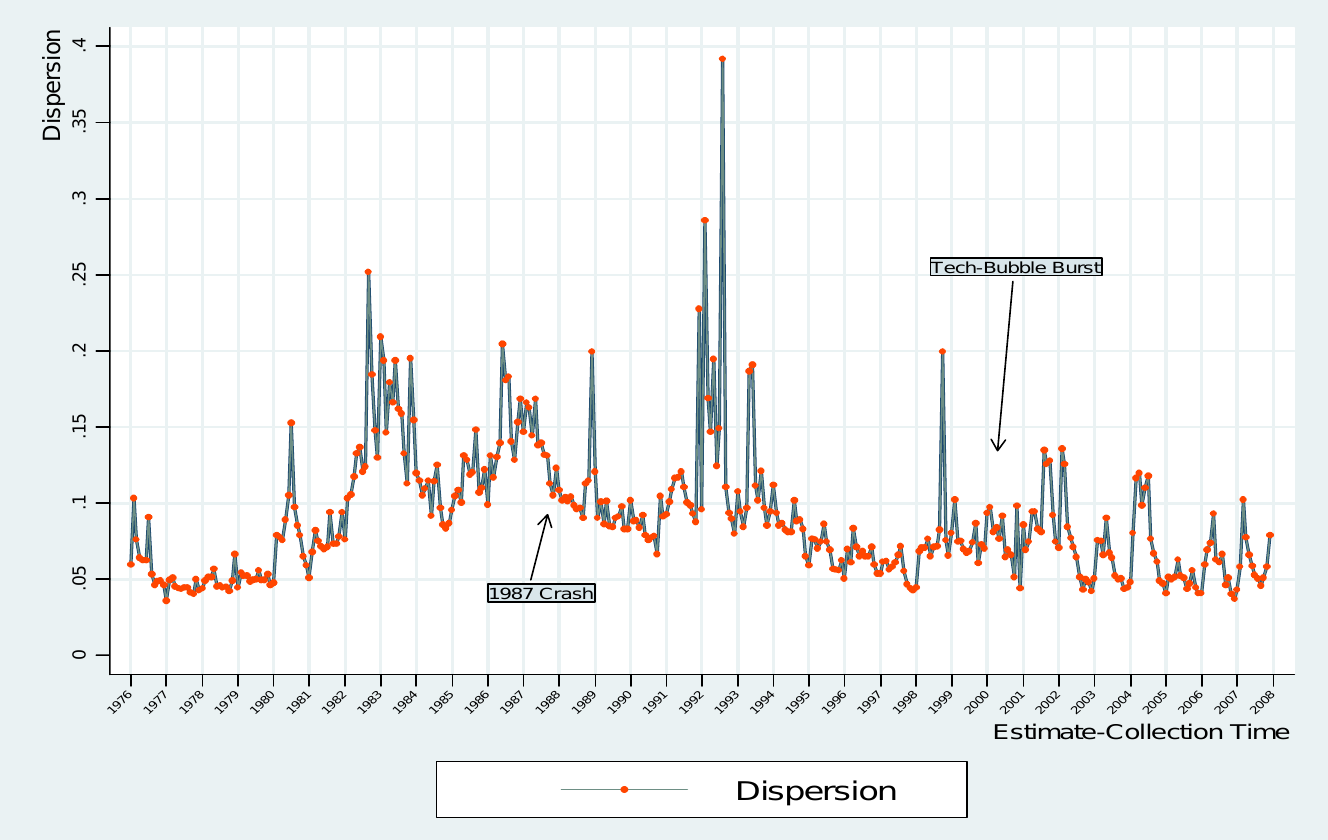
Figure 4: Monthly Average AFD (1976.1 -